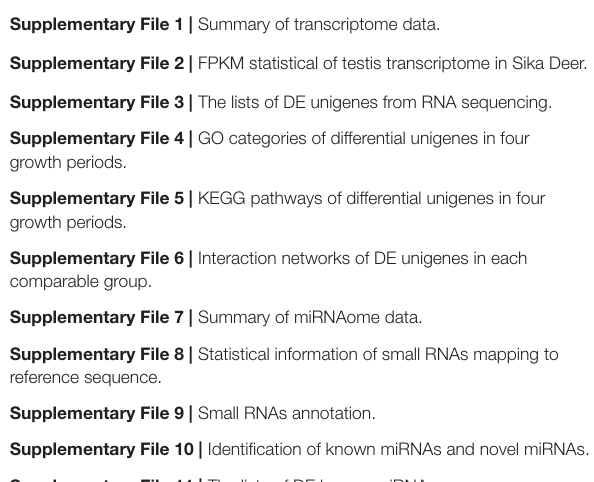
Supplementary Figure 1 | The top 20 GO categories of DE unigenes in each comparable group. Supplementary Figure 2 | The top 20 enriched KEGG pathways of DE unigenes in each comparable group. Supplementary Figure 3 | Characterization of miRNA-seq mapped reads from the small RNA sequencing of testis. Supplementary Figure 4 | The top 20 enriched GO terms for the potential genes targeted by DE miRNAs. Supplementary Figure 5 | The top 20 enriched KEGG pathways for the potential genes targeted by DE miRNAs. Supplementary File 1 | Summary of transcriptome data. Supplementary File 2 | FPKM statistical of testis transcriptome in Sika Deer. Supplementary File 3 | The lists of DE unigenes from RNA sequencing. Supplementary File 4 | GO categories of differential unigenes in four growth periods. Supplementary File 5 | KEGG pathways of differential unigenes in four growth periods. Supplementary File 6 | Interaction networks of DE unigenes in each comparable group. Supplementary File 7 | Summary of miRNAome data. Supplementary File 8 | Statistical information of small RNAs mapping to reference sequence. Supplementary File 9 | Small RNAs annotation. Supplementary File 10 | Identification of known miRNAs and novel miRNAs. Supplementary File 11 | The lists of DE known